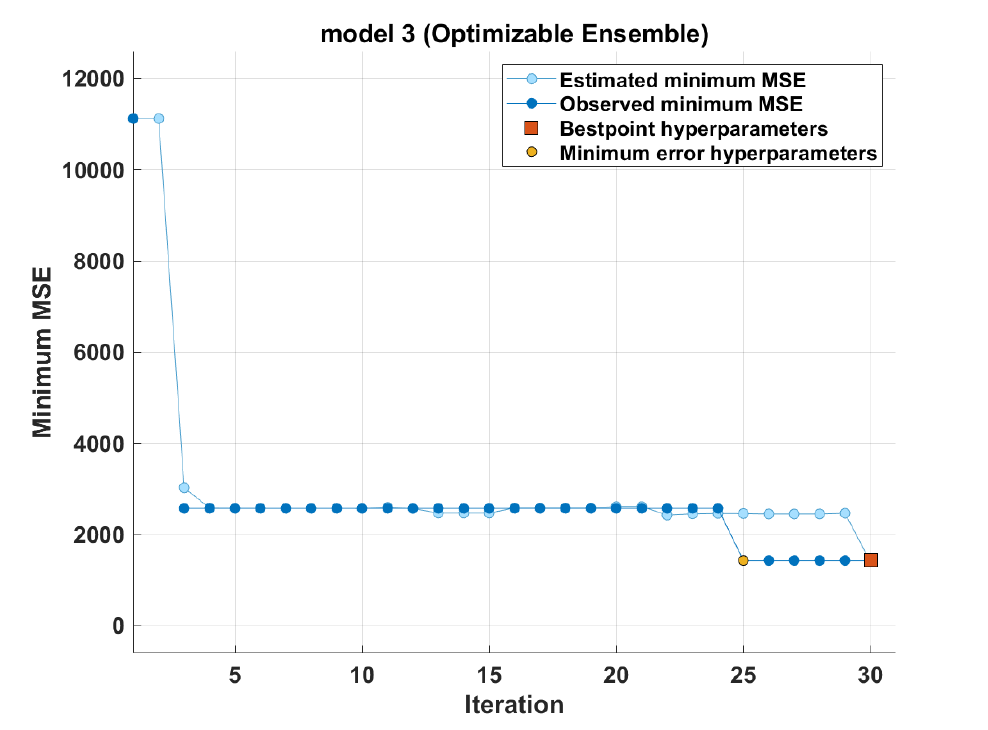
Figure 4. Visualization of the most optimal method—the boosted